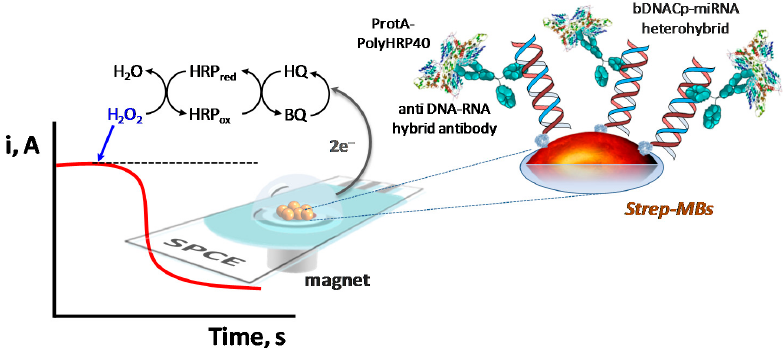
Figure 1. Schematic illustration of the fundamentals involved in the amperometric biosensor developed for the determination of microRNAs (miRNAs) based on the efficient formation of b- DNACp–miRNA heteroduplexes on the surface of Streptavidin-functionalized magnetic microcarriers (Strep-MBs) and their selective labeling with the anti-DNA–RNA hybrid antibody and ProtA–PolyHRP40. SPCE: screen-printed carbon electrode; b-DNACp: biotinylated complementary DNA